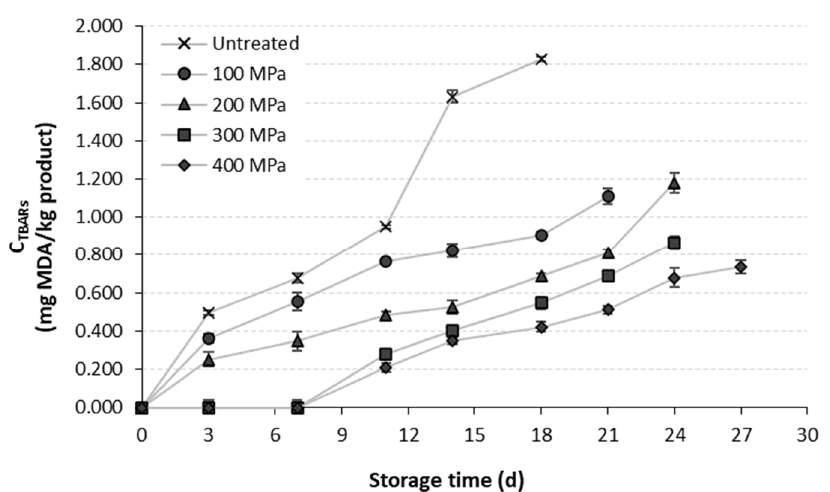
Figure 4. Evolution of lipid oxidation (in terms of malonic aldehyde concentration, mg MDA/kg product) of untreated European sea bass fillets and after HP processing at different pressures and ambient temperature for 10 min, and under aerobic storage. Each bar shows the standard deviation of four replicates ( n = 4).